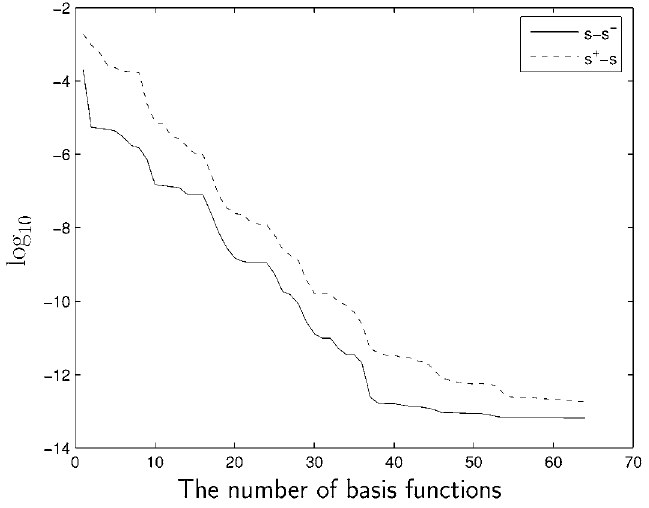
Figure 5. The bound gaps when varying two geometric parameters on a single bifurcation.